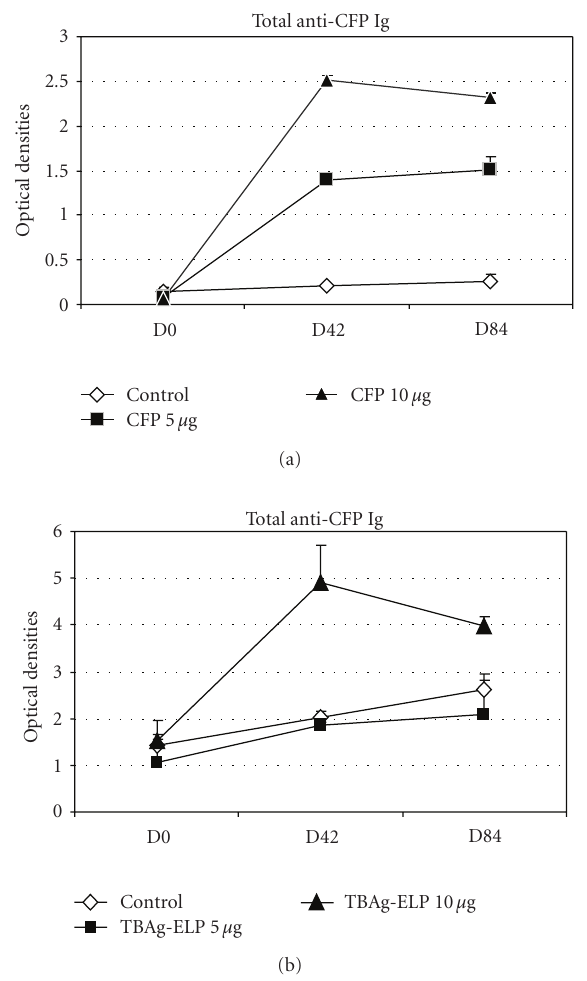
Figure 6: Kinetic of the anti-CFP humoral response from CFP and TBAg-immunized mice. Five groups of 4 mice were analysed. Two positive groups were injected with 5 and 10 μ g of CFP (upper graph) while the negative control group received 0.9% NaCl (both graphs). Two other groups were immunized with 2 doses (5 and 10 μ g) of purified TBAg-ELP (lower graph). Antigens were delivered in DDA/MPL by 3 SC injections on day 0, 14, and 28. Blood samples were taken on day 0, 42, and 84 and pooled. The anti-CFP response was analysed by ELISA using plates coated with 1 μ g/well of CFP. Diluted sera (1/50) were tested in triplicate. Total Igs were detected with HRP-labeled rabbit antimouse Ig antibodies. Absorbance was measured at 450 nm after TMB revelation and H 2 SO 4 treatment. Results are presented as mean ± standard deviation (SD).